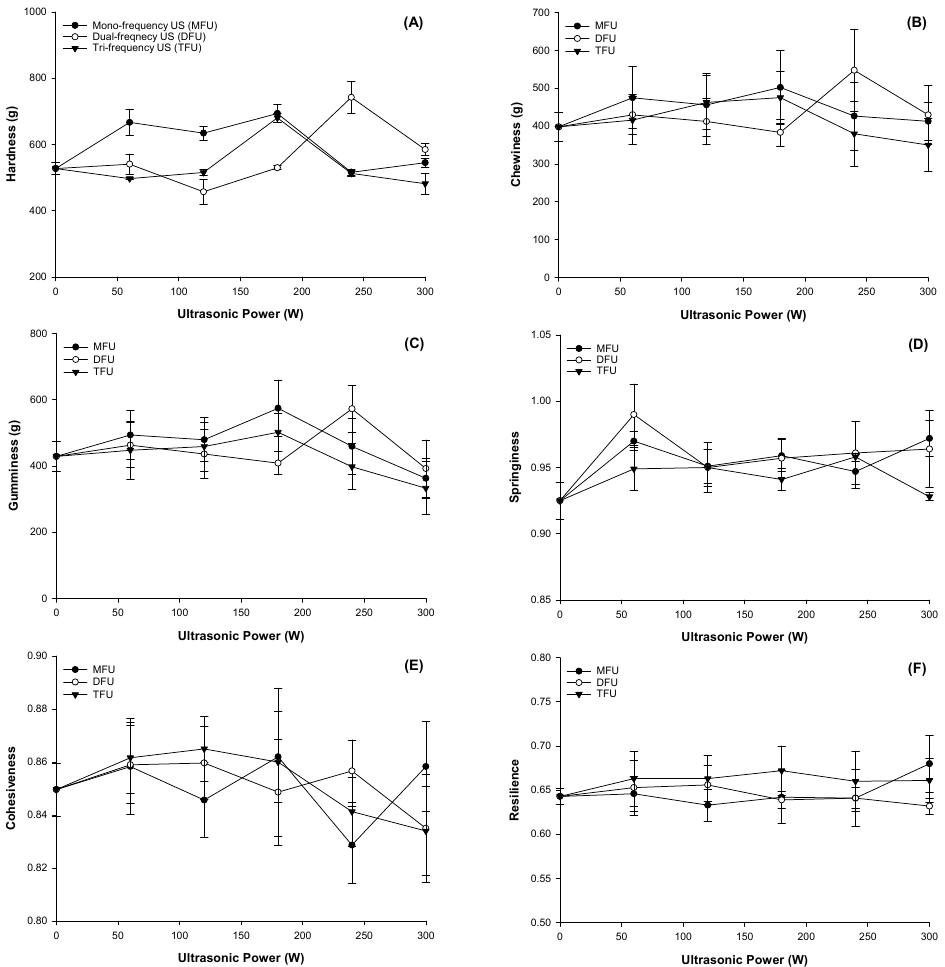
Figure 2. Texture profile analysis of WPEG with whey protein pretreated by ultrasound at different ultrasonic frequency mode and ultrasonic power: ( A ) Hardness; ( B ) Chewiness; ( C ) Gumminess; ( D ) Springiness; ( E ) Cohesiveness; ( F ) Resilience.